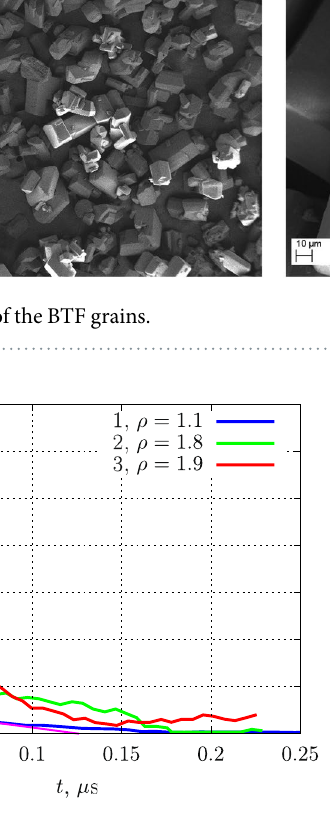
Figure 7. Electrical conductivity profiles in detonating BTF at different densities. For the density ρ = 1.1 g/cm 3 a procedure defining the peak width is shown.